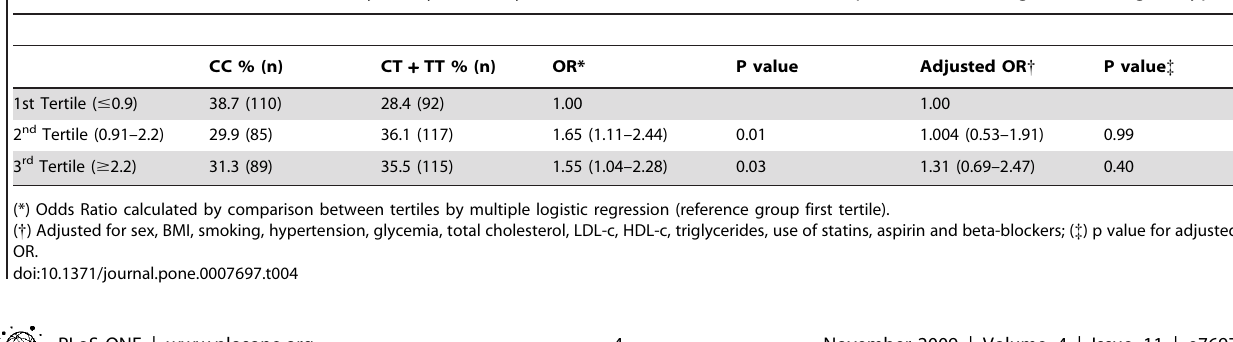
Table 4. Tertile distribution of severity artery coronary lesions score (SCS) in non-diabetic patients according to TCF7L2 genotypes.